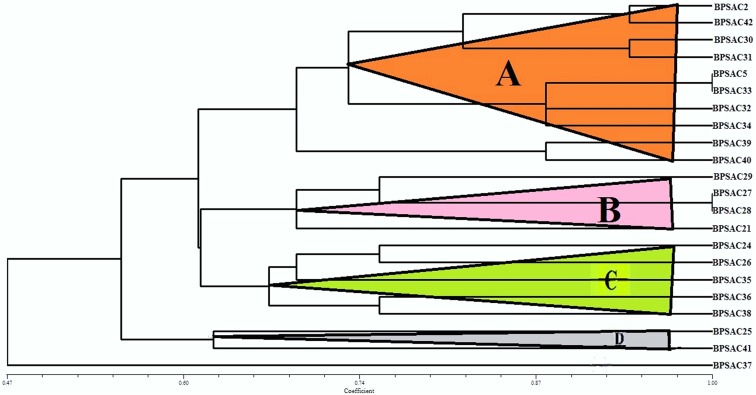
Dendrogram generated from ERIC PCR genomic fingerprints of endophytic actinomycetes isolates using Ntsys 2.0.